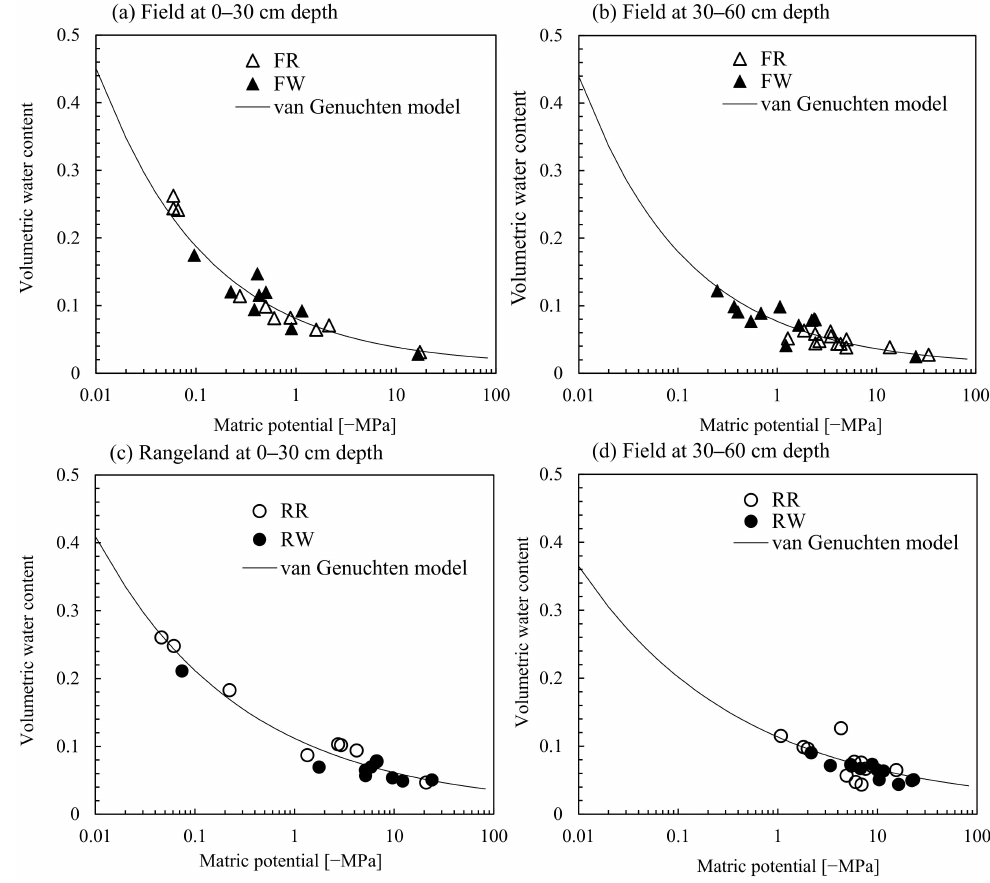
Figure 5. Relationships between the matric potential and water content, which were measured in August 2016, April 2017, and June 2018 ( a ) at 0–30 cm depth and ( b ) 30–60 cm at two field sites,